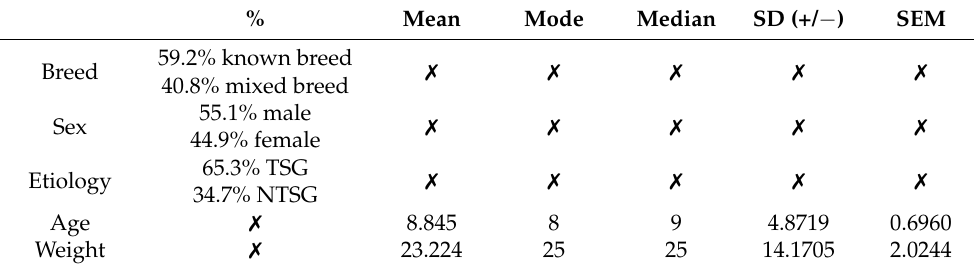
Table 3. Sample population characterization.